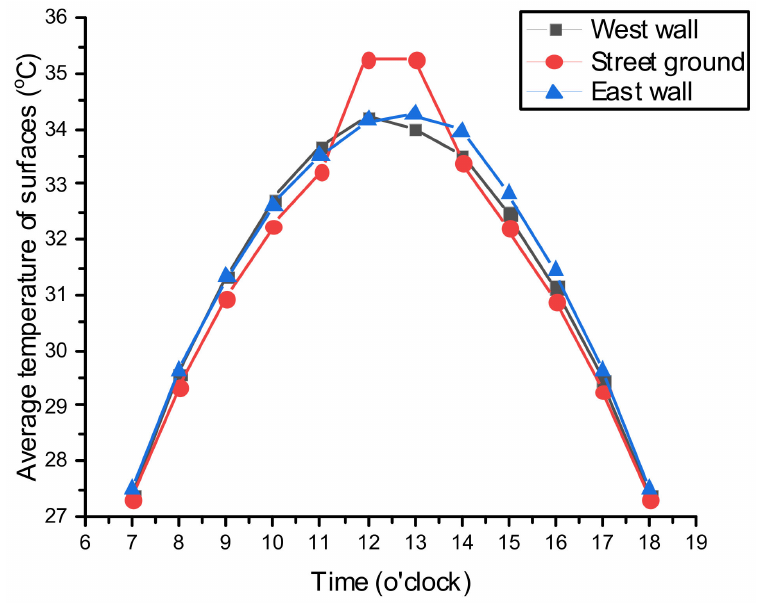
Figure 18. Variation of the hourly average temperature on the west wall, street ground, and east wall, with an aspect ratio of